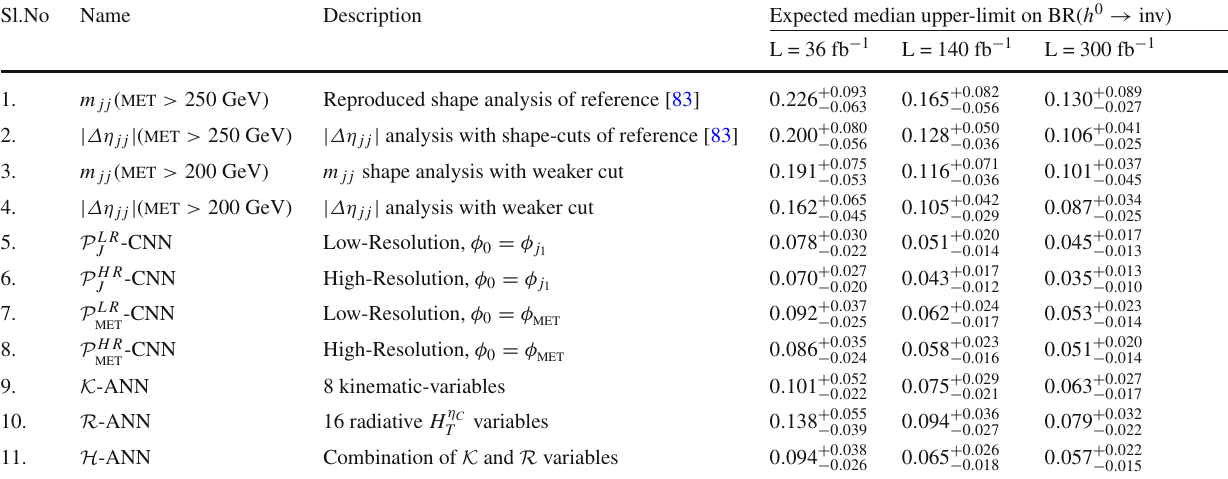
Table 1 Short description of the different analyses shown in Fig. 15 and the expected median upper-limit on BR( h 0 → inv) at 95% CL for each integrated luminosities which also include projections for L = 300 fb − 1